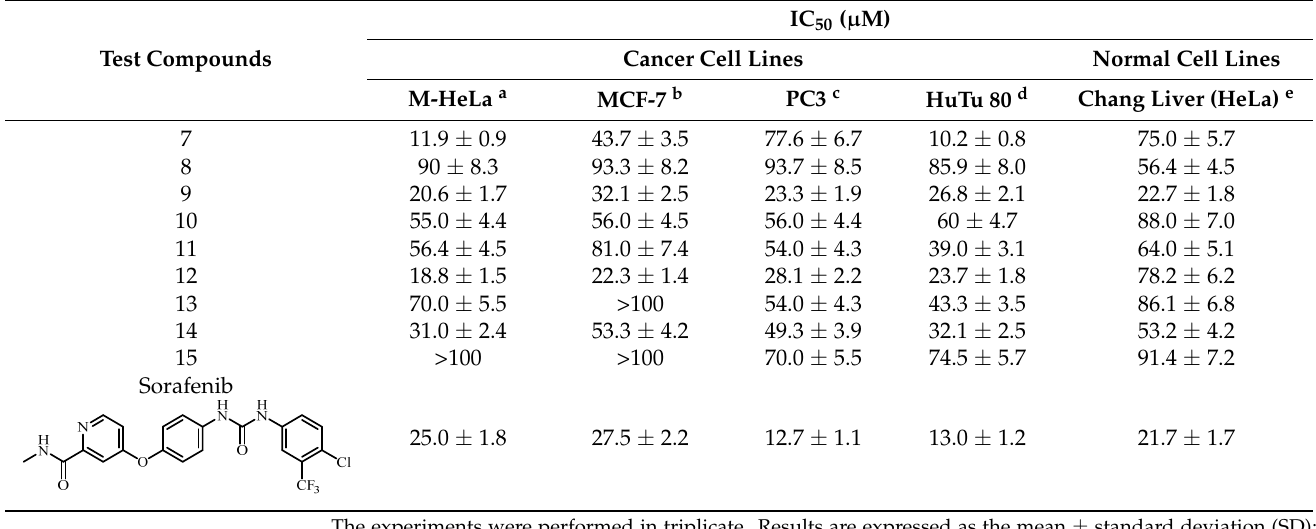
Table 1. Cytotoxic effects (IC 50 , µ M) of test-compounds.